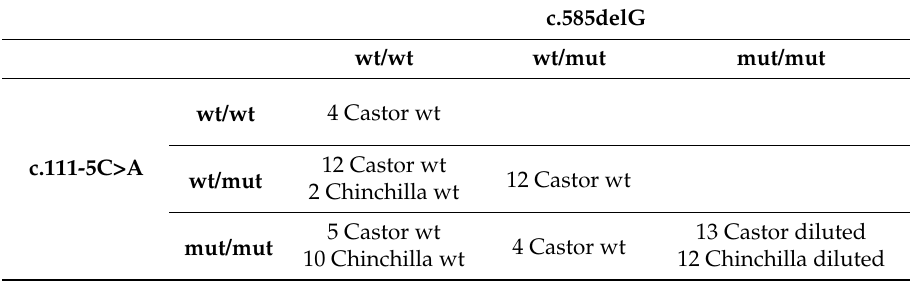
Table 1. Association of both variants in rabbits from Castor and Chinchilla breeds. A total of 74